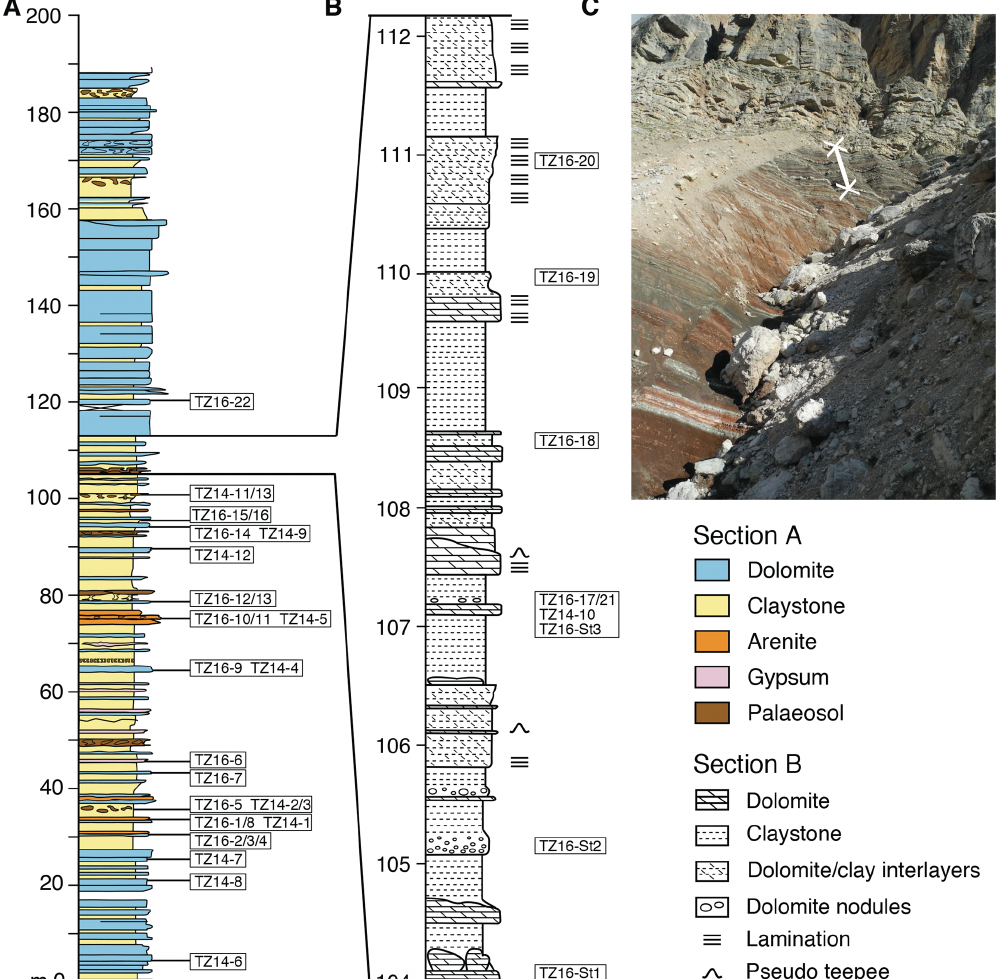
Figure 2. Stratigraphic section at Rifugio Dibona: (a) complete section modified after Breda and Preto (2011), showing sampling loca- tions; (b) detailed section of the uppermost part of the clay-rich interval, showing sampling locations. (c) Outcrop photograph showing the uppermost grey part of the clay-rich interval including the location of the profile shown in (b)